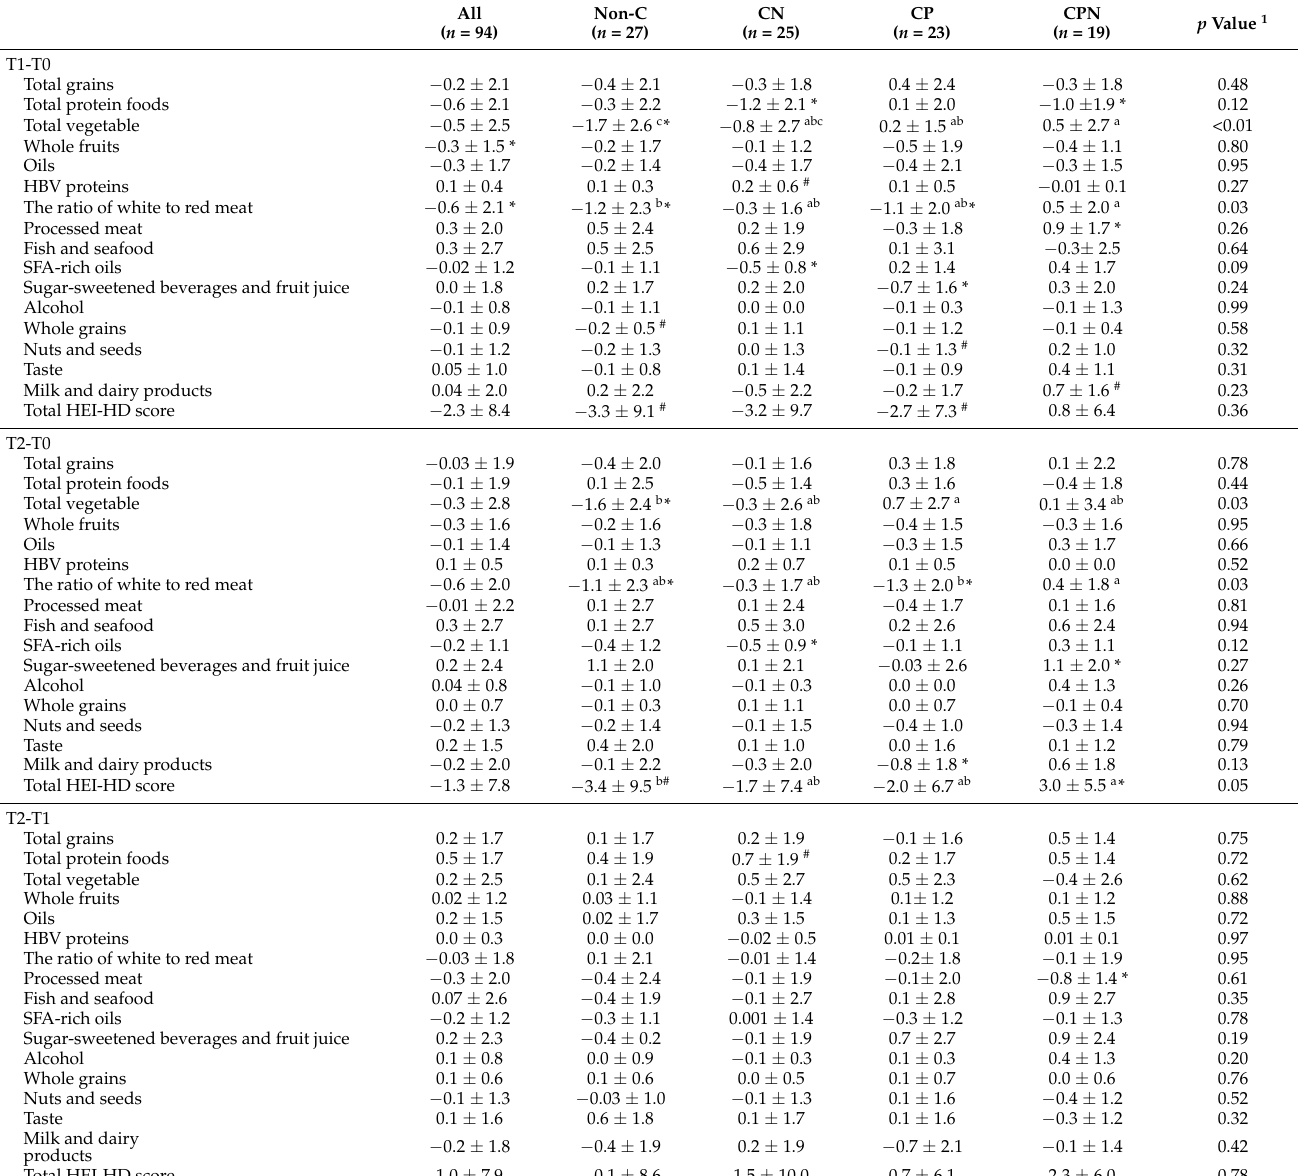
Table 4. Changes in the HEI-HD and its 16 items score in different nutritional education